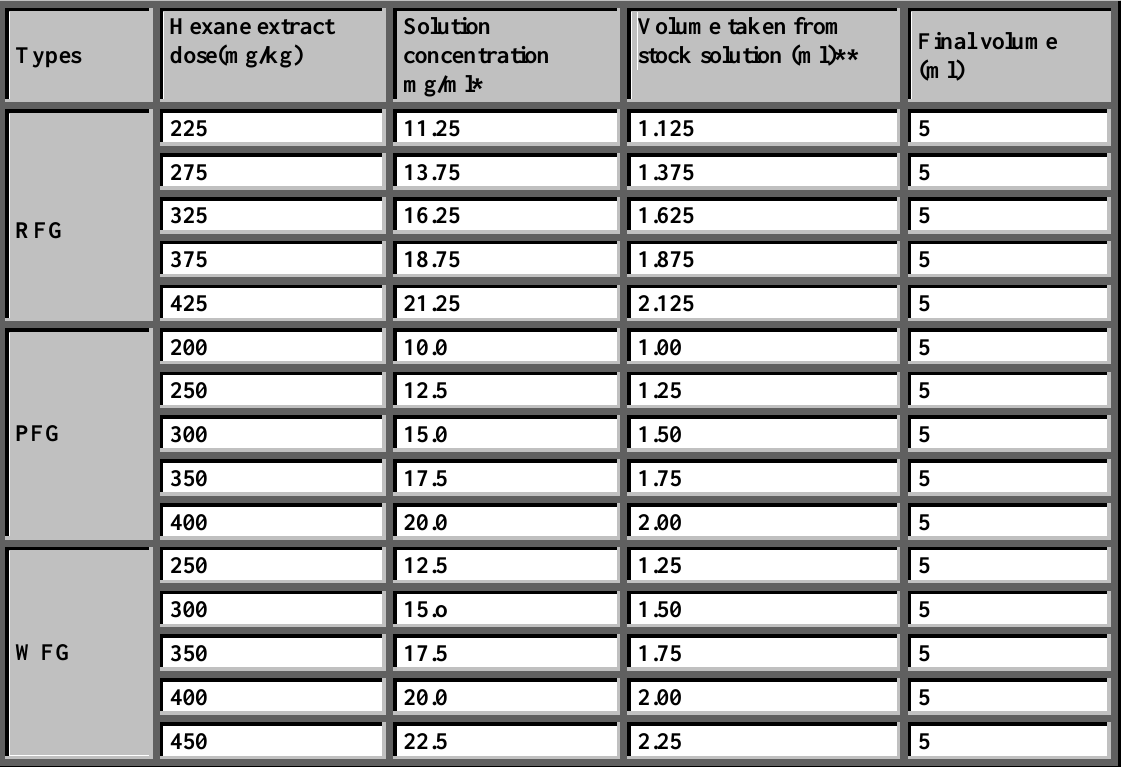
Table 1: Doses and dilutions of N.oleander of hexane extract.